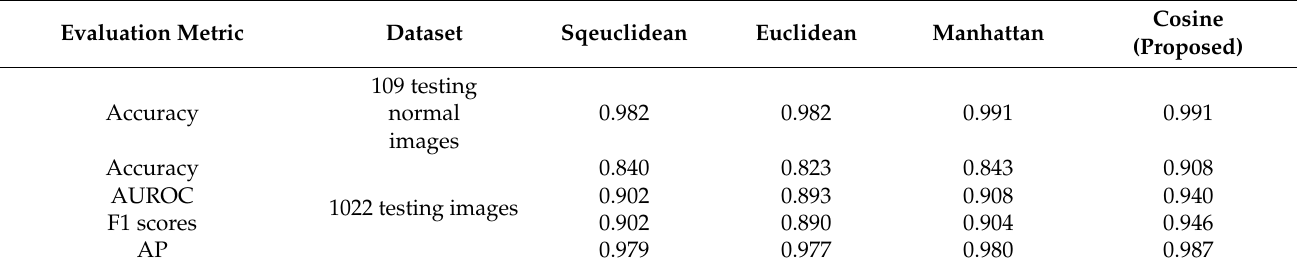
Table 8. Quantitative comparisons with other distance